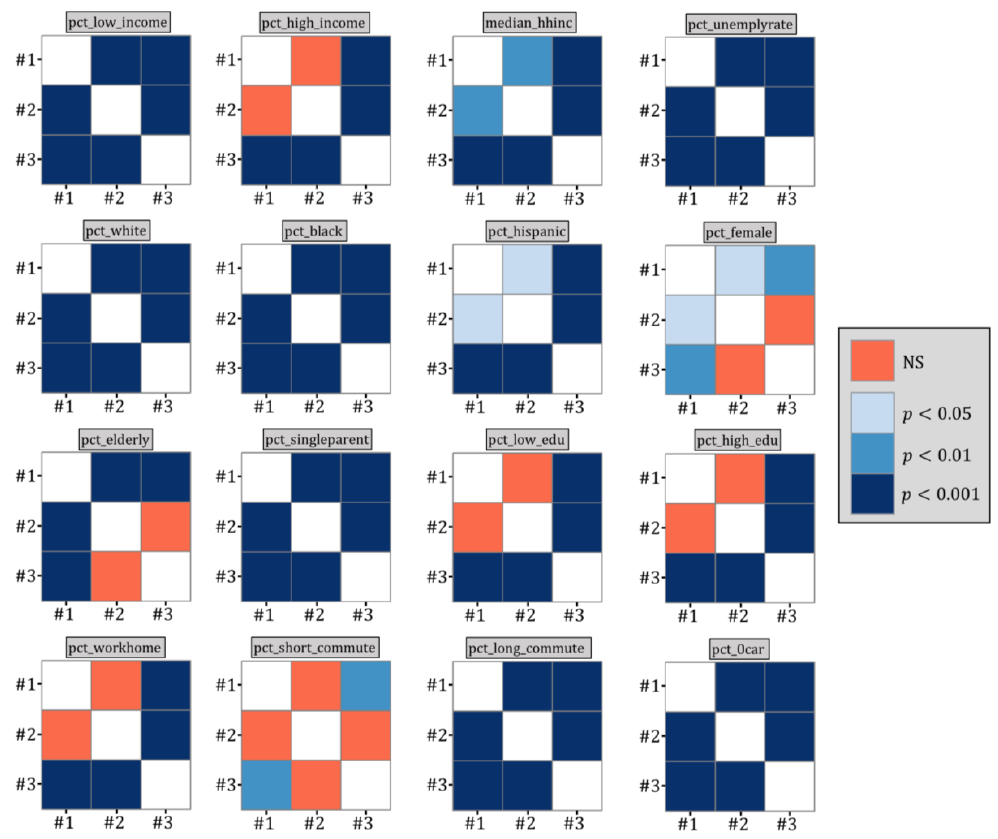
Figure 7. Post-hoc Tukey’s test for selected variables between pairs of clusters. NS demotes Figure 7. Post- hoc Tukey’s test for selected variables between pairs of clusters. NS demotes “not significant” ( 𝑝 ≥ 0.05 ). “not significant” ( p ≥